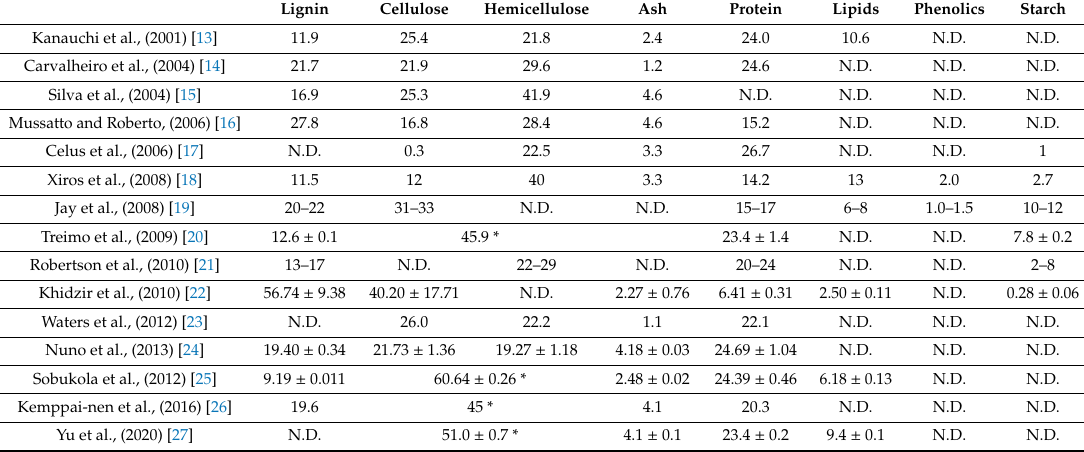
Table 1. The approximate chemical composition of BSG in di ff erent studies (% of dry weight). Lignin